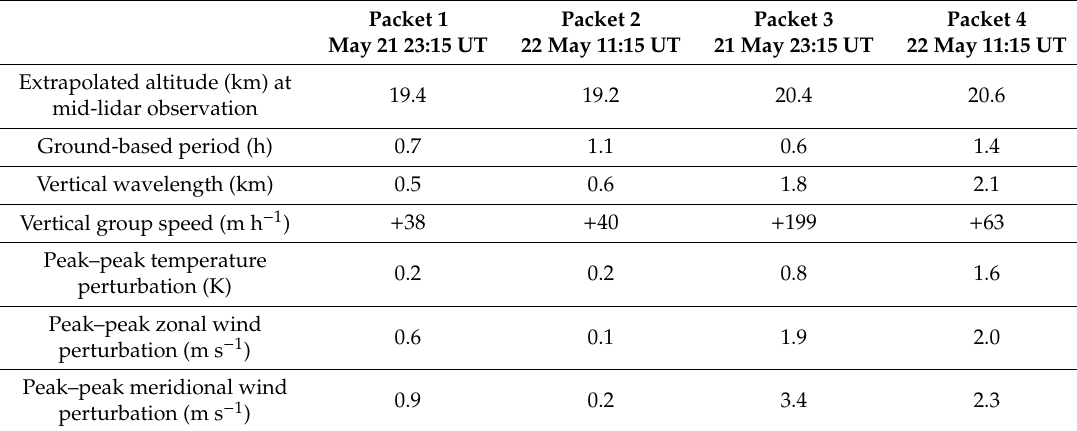
Table 3. Parameters for analysed gravity wave packets relevant to the Kingston lidar observation on 22 May